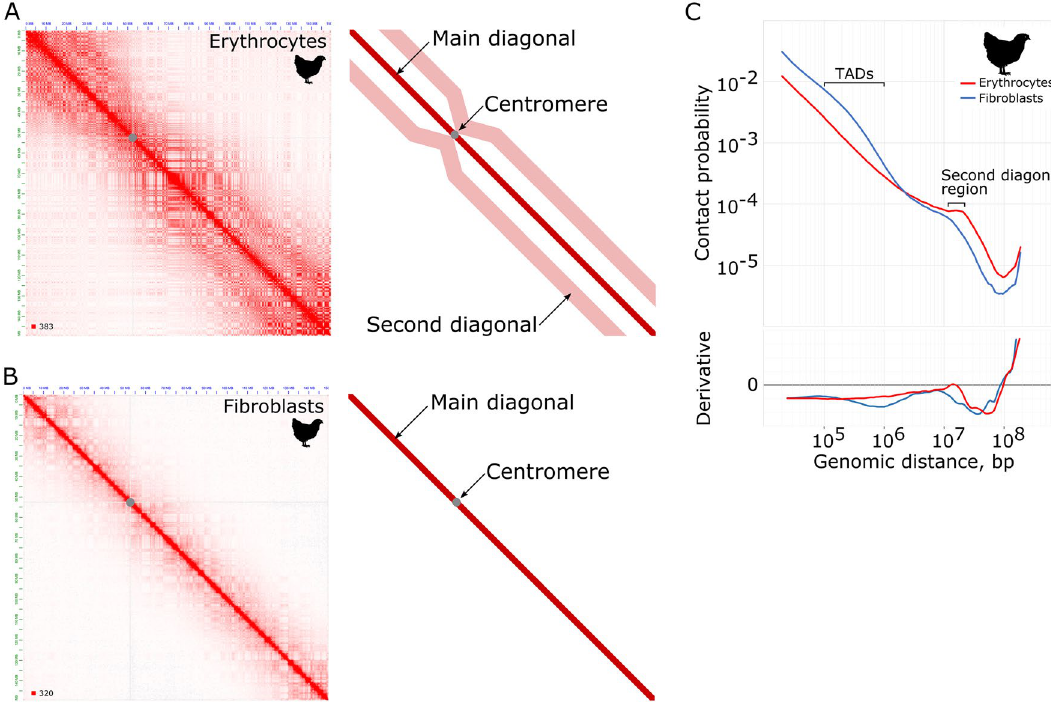
Figure 1. The key features of the erythrocytes’ genome organization on the example of chicken. ( A ) Hi-C contact heatmaps of erythrocytes (left) and a schematic representation of the map with the second diagonal marked (right). ( B ) Hi-C contact heatmaps of fibroblasts (left) and a schematic representation of the map (right). ( C ) The dependence of the contact probability on the genomic distance P(s) averaged over all chromosomes for chicken erythrocytes and fibroblasts. Bottom panel: derivatives of P(s) curves. Note that the shape of the curves differs in TADs typical size region and in the second diagonal region. Hi-C maps were visualized with Juicebox (version 1.11.08) 7